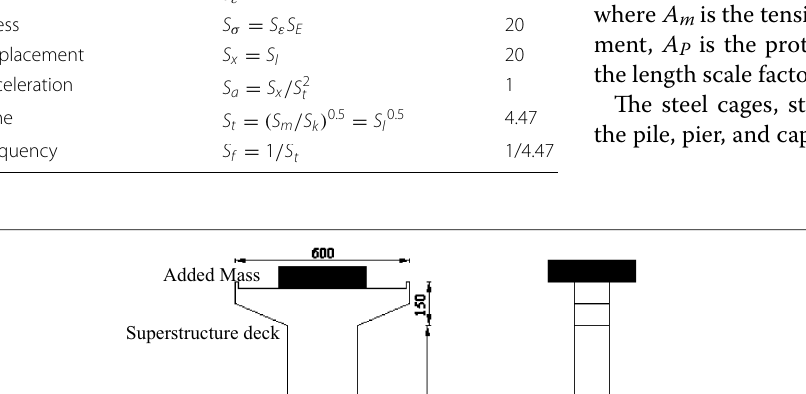
Table 1, to provide scaled bar yielding force and as pre- sented in the following equation: